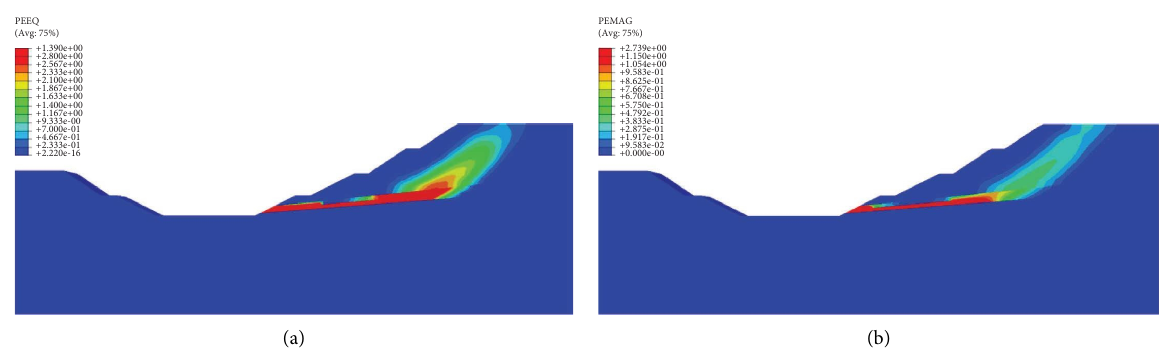
Figure 9: Te most dangerous sliding surface under check condition. (a) Equivalent plastic strain nephogram; (b) cumulative plastic strain